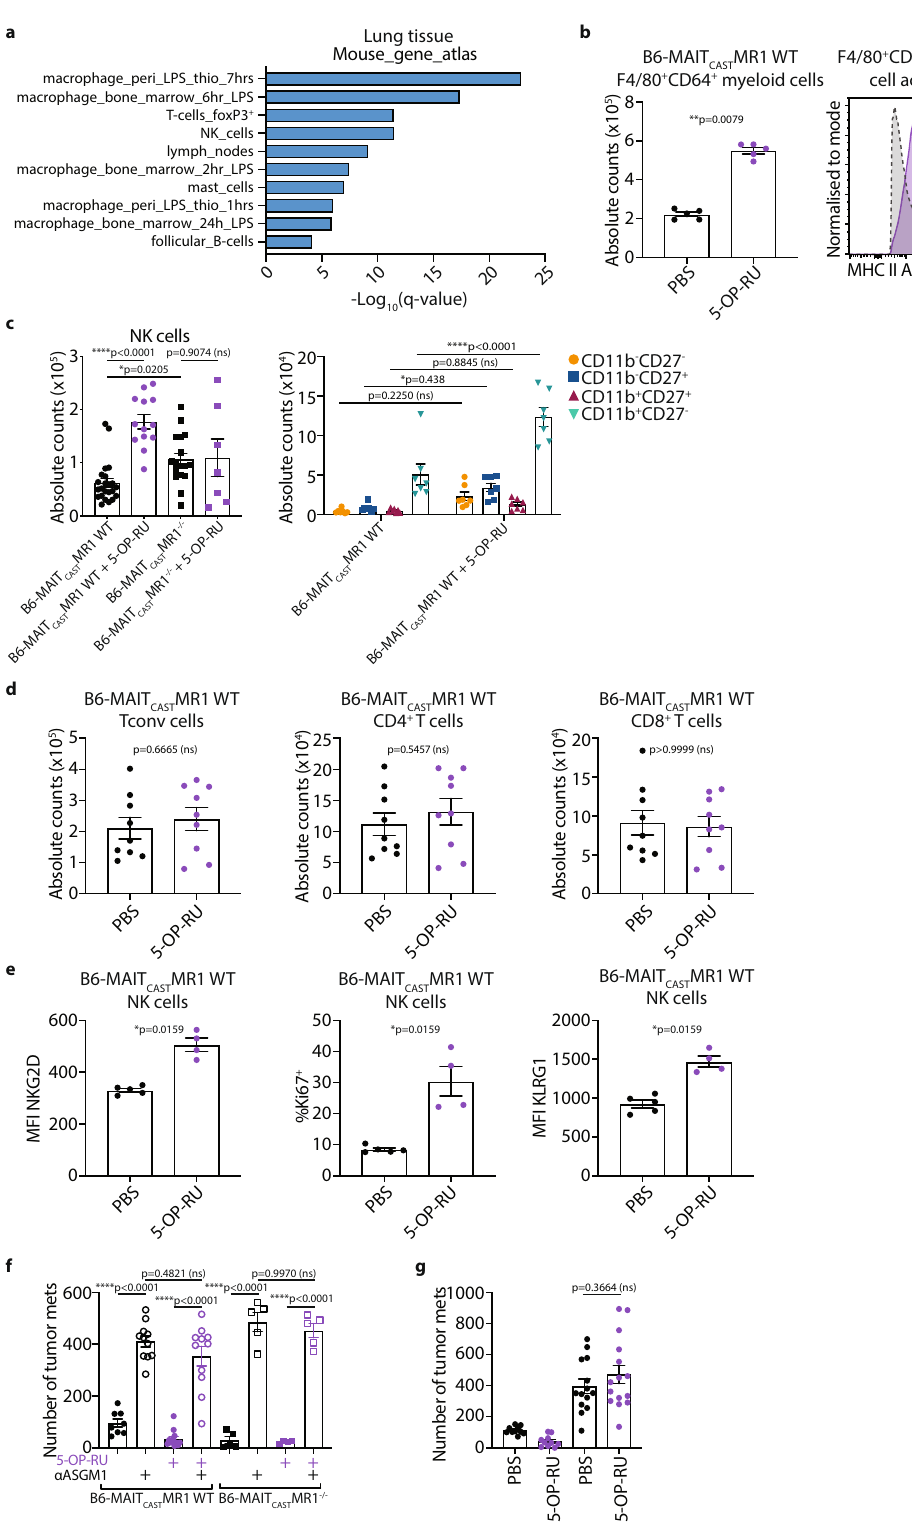
cell axis using a melanoma sample identi fi ed to have a higher MAIT cell frequency (0.78% of live cells, compared to <0.1% in Fig. 6f, g). 5- OP-RU treatment signi fi cantly increased the number of IFN- γ and TNF-positive NK cells, con fi rming that NK-MAIT cell cross talk can